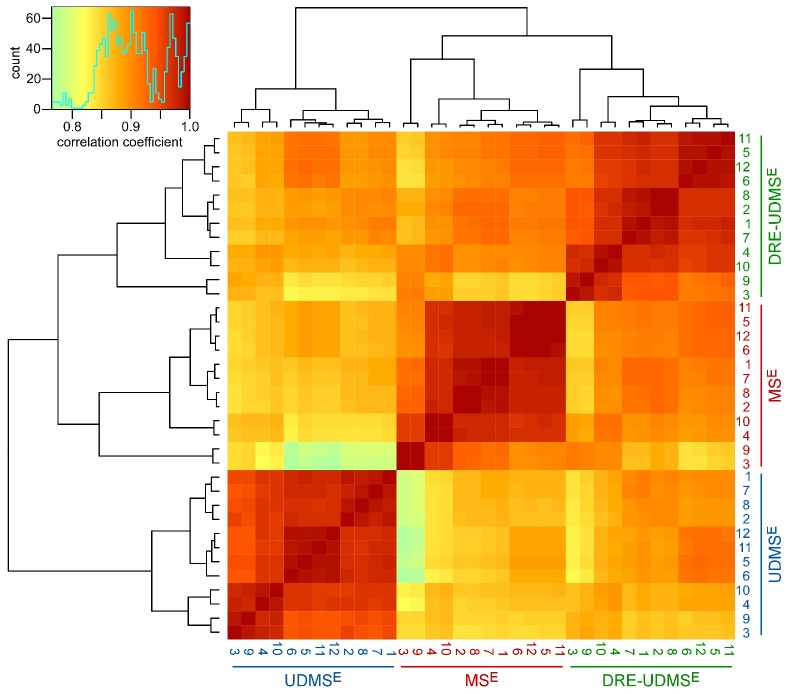
Clustered heatmap of Pearson’s correlation coefficients for protein abundance comparing data acquisition modes.The heatmap compares the log2 transformed ppm protein abundance values to assess peripheral myelin purified from wild type mice using three data acquisition modes (MSE, UDMSE, DRE-UDMSE). The inset shows the color key and the histogram for the values of the correlation coefficients. Note that the runs cluster with a high overall correlation (>0.75) into three conditions defined by the acquisition mode, in agreement with the experimental design. Among the samples analyzed by different acquisition modes, DRE-UDMSE similarly correlates with both MSE and UDMSE, reflecting its intermediate nature.